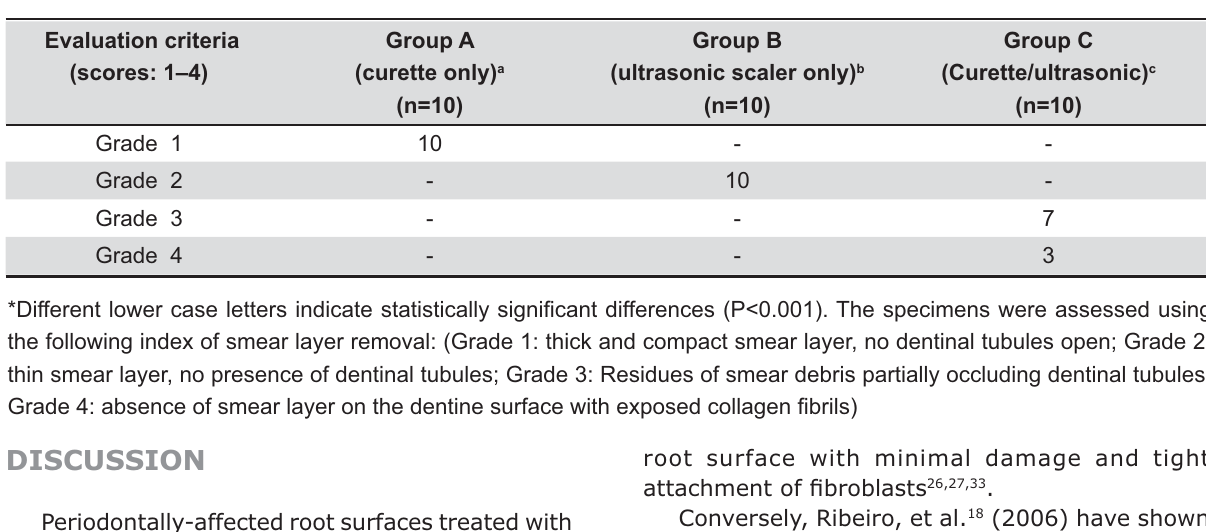
Table 1- Distribution of the scores for morphological characteristics of the root surface Evaluation criteria